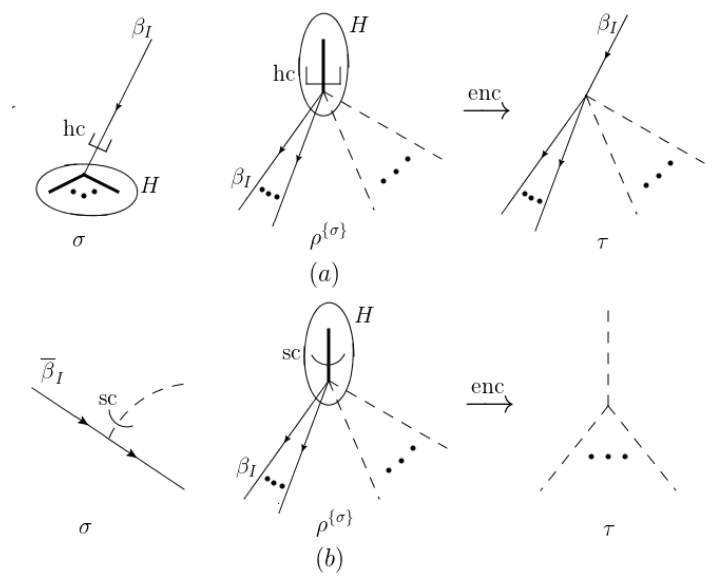
Figure 25. The two generic hard-exotic con(cid:12)gurations. The upper row is from the hard-collinear approximation, while the lower is from the soft-collinear. The con(cid:12)gurations corresponding to (cid:2) (cid:3) (cid:28) (cid:17) enc (cid:27); (cid:26) f (cid:27) g are drawn at the rightmost. The intermediate dots indicates that there can be one or two lines, but at each vertex the total number of lines attached does not exceed